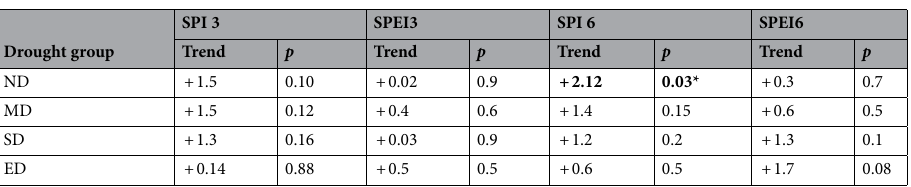
Table 4. Trends and significance of drought proportion over Hungary between 1961 and 2010. *Significant p < 0.05. Significant values are given in